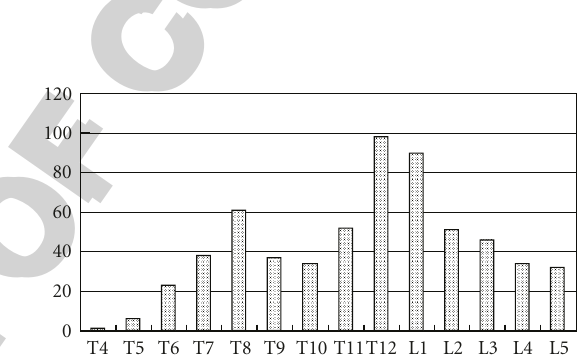
Figure 2: Distribution of vertebral fractures. Two peaks in the distribution of vertebral fractures were observed: the number of vertebral fractures was greatest in the 12th thoracic and 1st lumbar spine, followed by the 8th thoracic